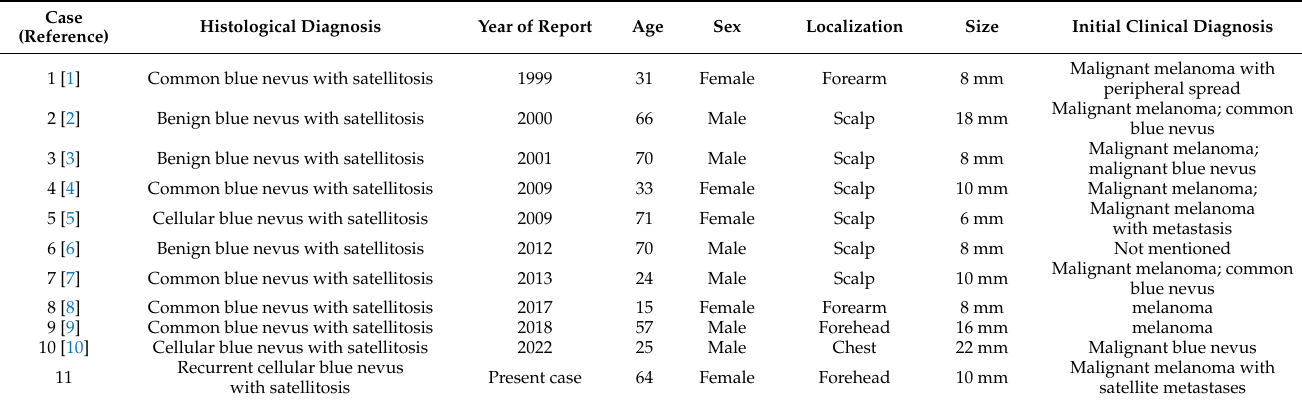
Table 1. Overview on cases of blue nevi with satellitosis reported in the